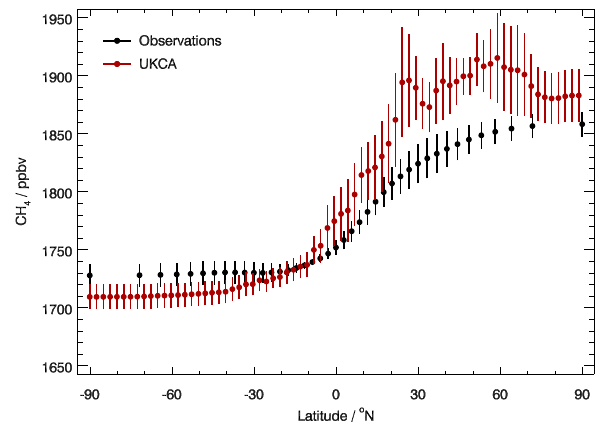
Fig. 14. Comparison between multi-annual latitudinal profiles of observed and modelled surface CH 4 concentrations with surface observations from GLOBALVIEW-CH 4 (2009). Every second model latitude is omitted from the plot for the purpose of clarity.